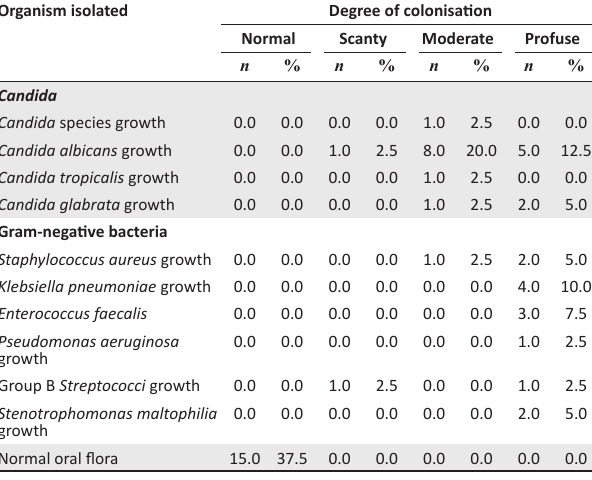
TABLE 5: Bacterial organisms isolated from the oral cavities of participants and the degree of colonisation. Organism isolated